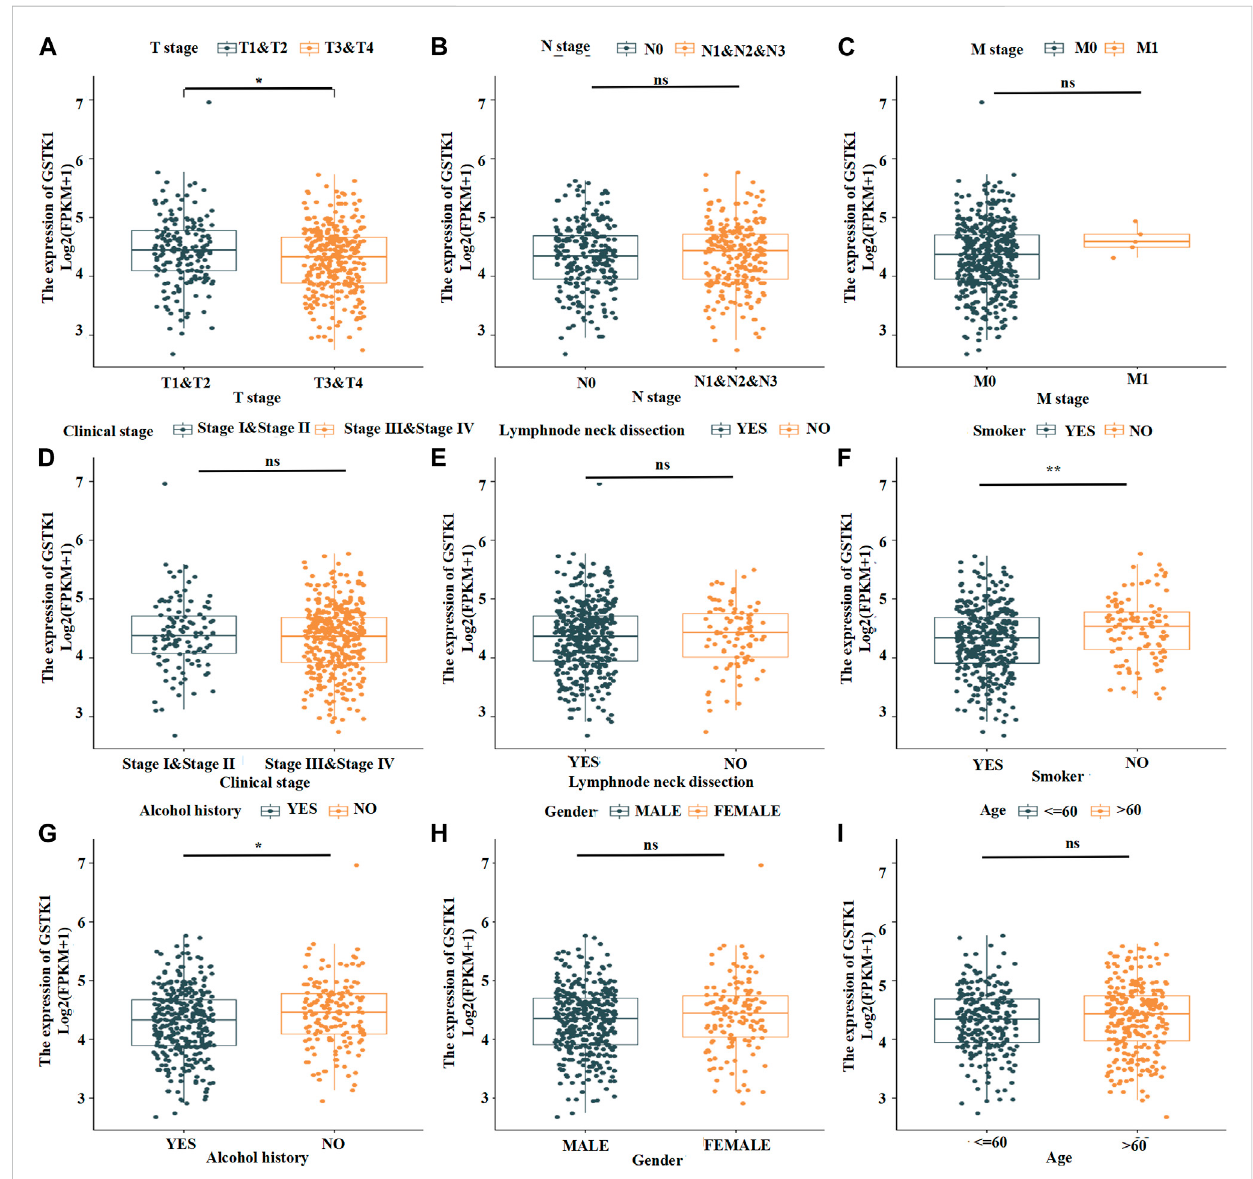
FIGURE 3 Expression patterns of GSTK1 mRNA in the tumors of patients with different clinical characteristics in TCGA. (A) The most signi fi cant difference was from T stage 1-2 to T stage 3-4. (B) Expression was not signi fi cantly different from N stage 0 to N stage 1 – 3. (C) The mRNA was not signi fi cantly different from M stage 0 to M stage 1. (D) Expression in Clinical stage III-IV was lower than stage I-II but not signi fi cantly different. (E) Expression in HNSC tumors following a lymph node dissection was lower than those who did not undergo a lymph node dissection but not signi fi cantly different. (F, G) mRNA expression was much lower in HNSC patients with a smoking and signi fi cant alcohol history. (H, I) mRNA expression did not differ between gender and age. (* p < 0.05, ** p < 0.01, *** p <